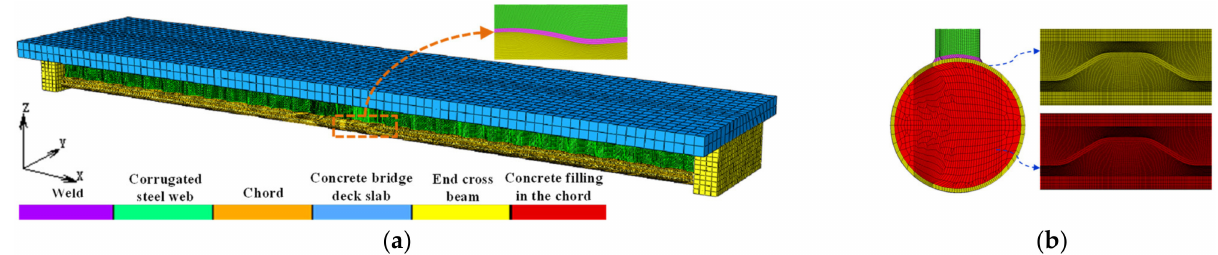
Figure 16. Mesh of numerical model: ( a ) entire model; and ( b ) concrete in